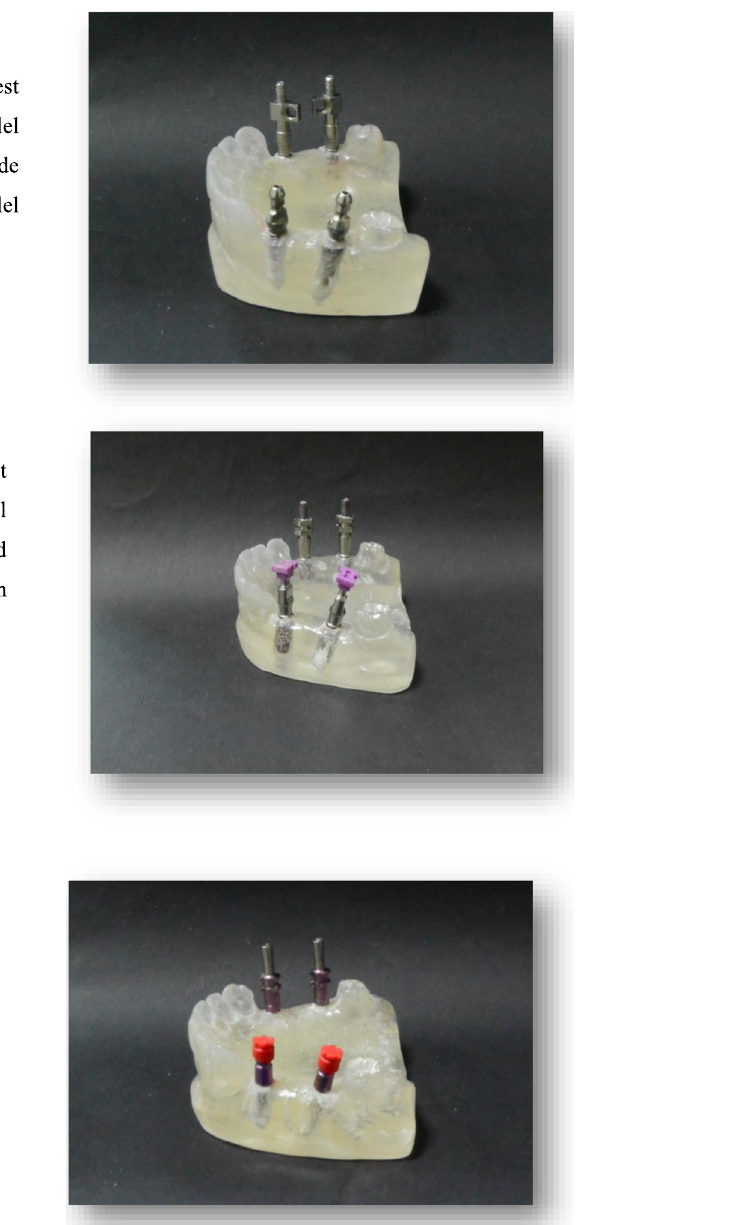
Fig. 2 a Osstem test model with two parallel implants on the left side and two nonparallel implants on the right side. b Straumann test model with two parallel implants on the left side and two nonparallel implants on the right side. c SIC Invent test model with two parallel implants on the left side and two nonparallel implants on the right